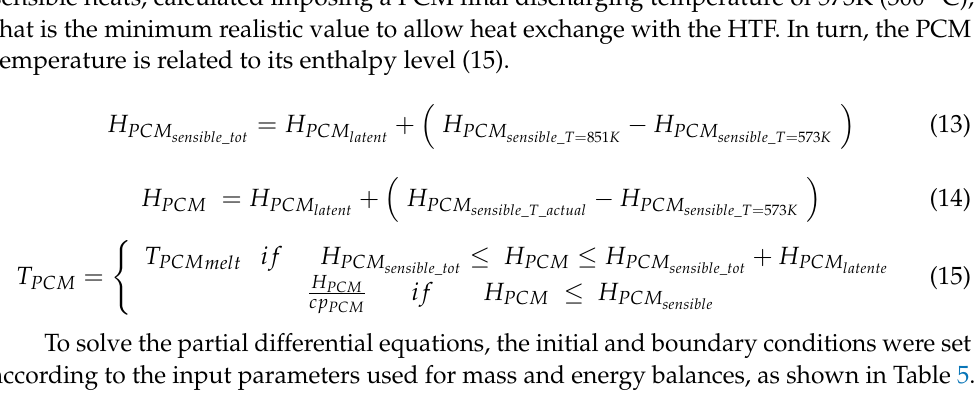
Table 5. Boundary conditions related to (11) and (12).